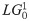
Polarization dependence at varying focal strength.Intensity profiles of LG01 beams with (from left to right) N.A. = 0.1, 1.0, and 1.4. Linear (dashed line), RHC (aligned, circles), and LHC (anti-aligned, crosses). As the N.A. increases, the intensity profile becomes increasingly dependent on the polarization.